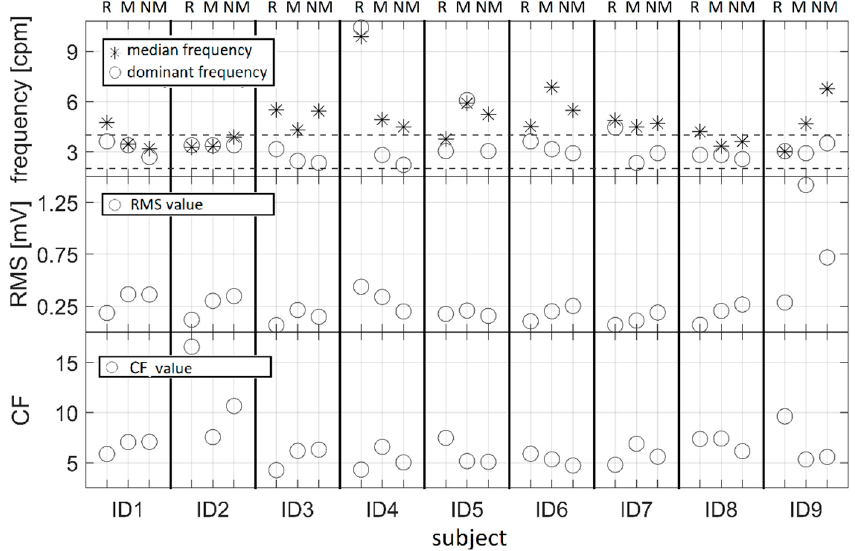
Figure 7. Dominant frequencies, median frequencies (upper panel), RMS (middle panel), and CF (bottom panel) values calculated for all sequences during EGG recordings and obtained in 9 subjects (ID1-ID9). Abbreviations R, M, and NM stand for resting, motion, and no motion.